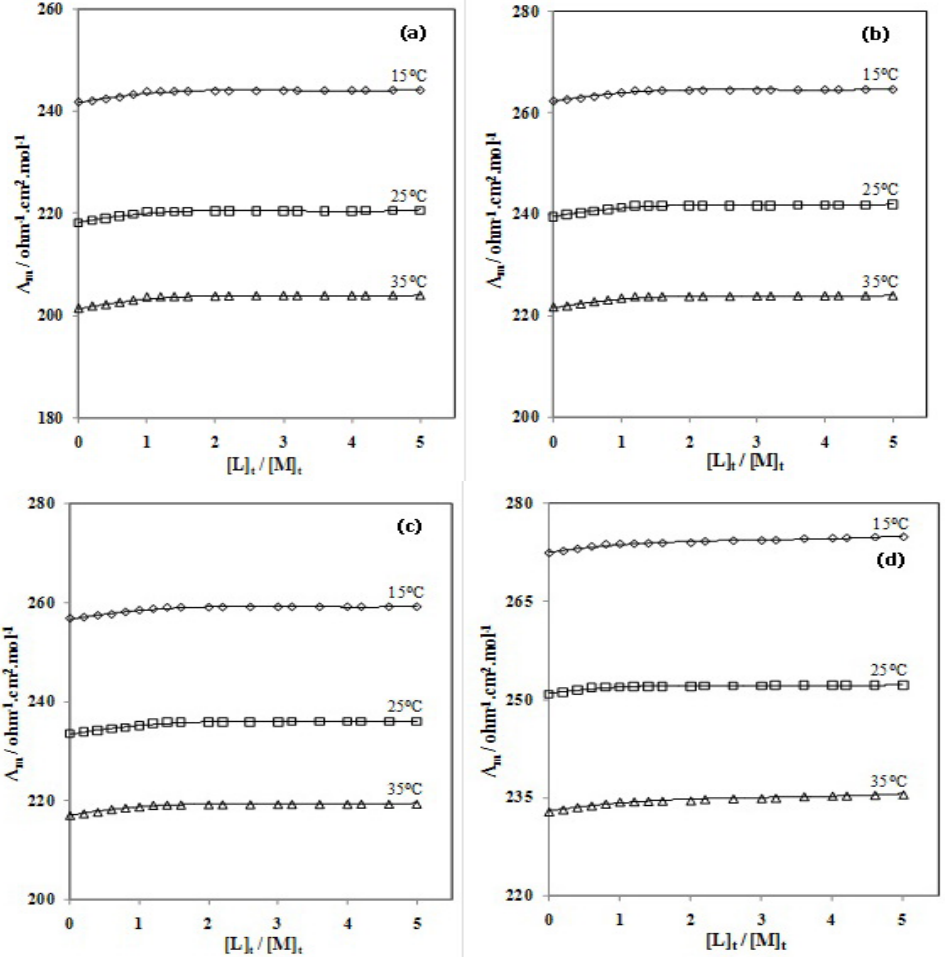
Figure 3. Molar conductance (S cm 2 .mol − 1 ) vs . [CMCR]/[Ti(OH)(OH O binary mixture (mol% H in AN–H 2 various